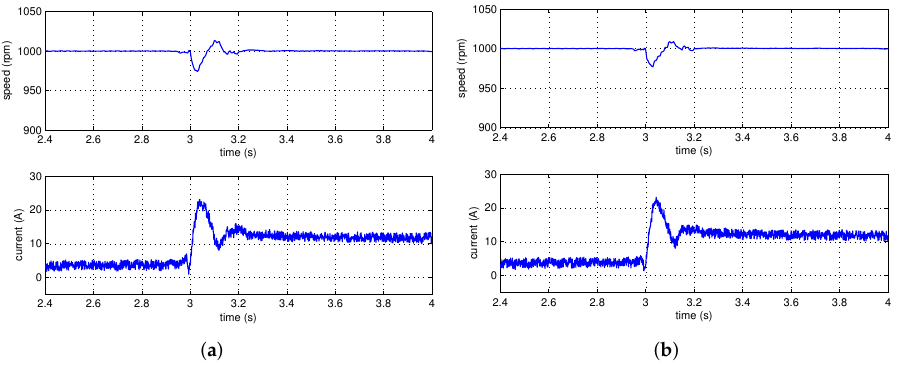
Figure 8. Load disturbance response comparisons. ( a ) IOPD-ESO. ( b )